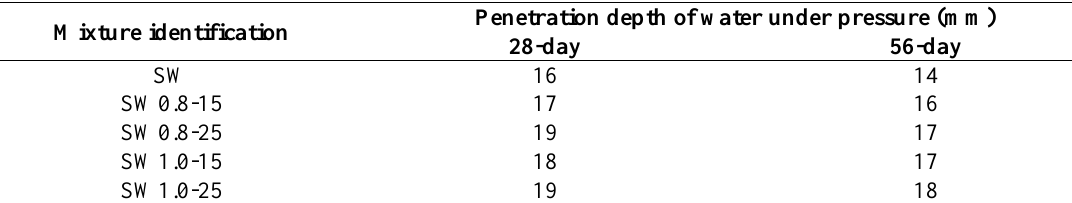
Table 9. Water penetration depth